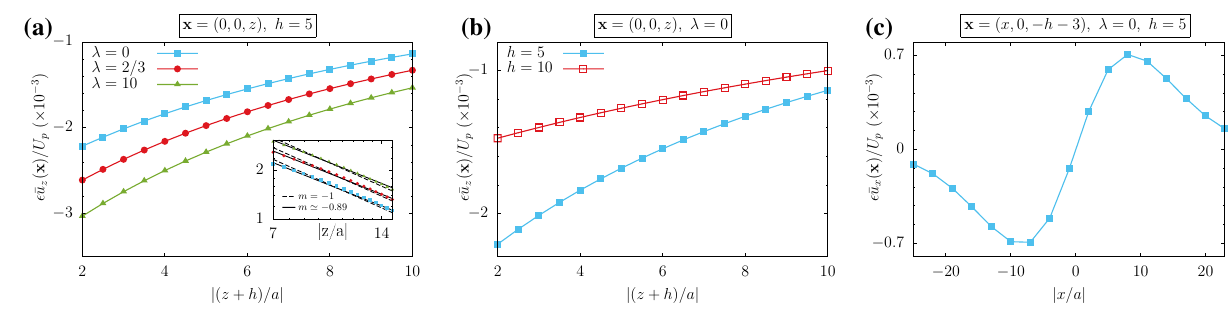
Figure 8. ( a ) Averaged pumping velocity in terms of the distance from the wall for various values of (cid:31) . Absolute value of the velocity will increase for larger values of (cid:31) . Inset shows power law fittings in logarithmic 0.89 that is very near to the scaling behavior m 1 resulted from scale. Velocity scales as z m , with m = − = − dimensional analysis. ( b ) The pumping velocity for different values of h . ( c ) Parallel component of the flow just 0.1 , other parameters are mentioned in the below the particle, has left-right symmetry. Including Ca =